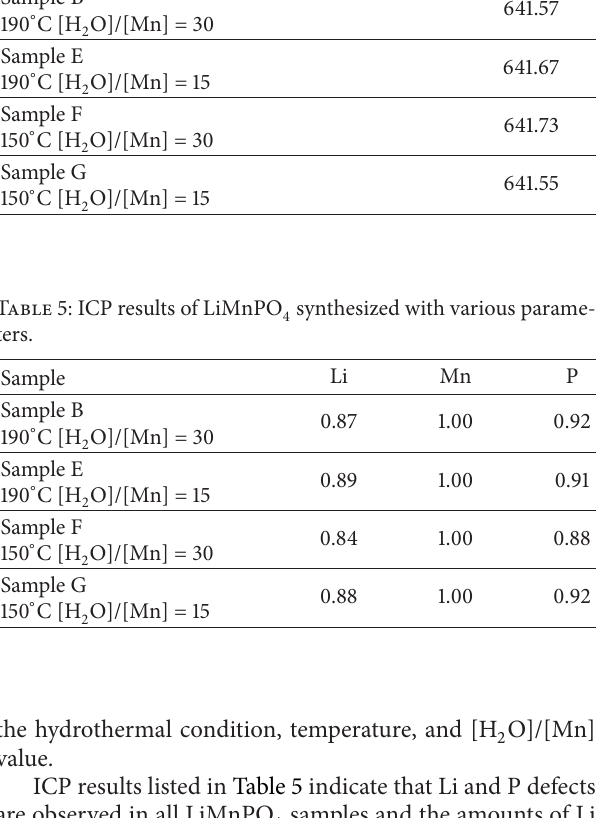
curves of samples synthesized from MnAc (samples A and B) indicate coexistence of plateau of LiMnPO 4 and MnPO 4 near 4 V with 40 mAh/g discharge capacity at 1/20 𝐶 rate.